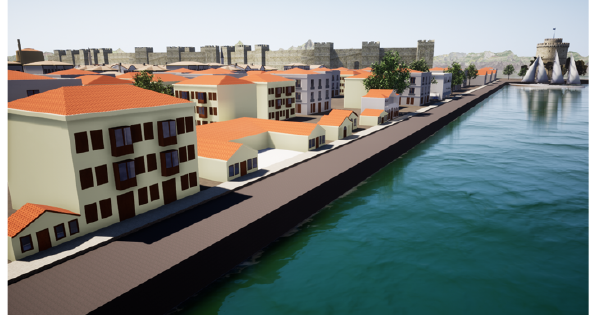
Figure 7. 3D render of Quay of Thessaloniki further developed for VR